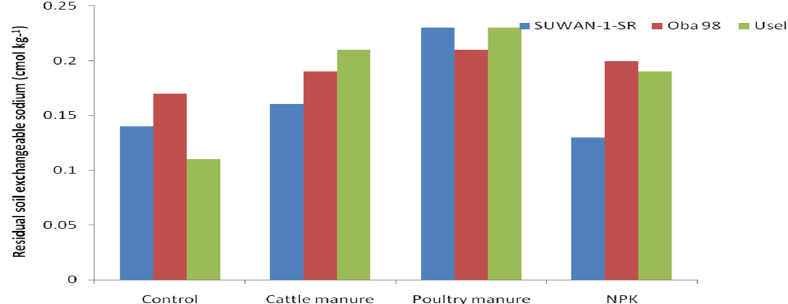
Figure 4. Interaction of maize variety and soil amendment on residual soil exchangeable sodium